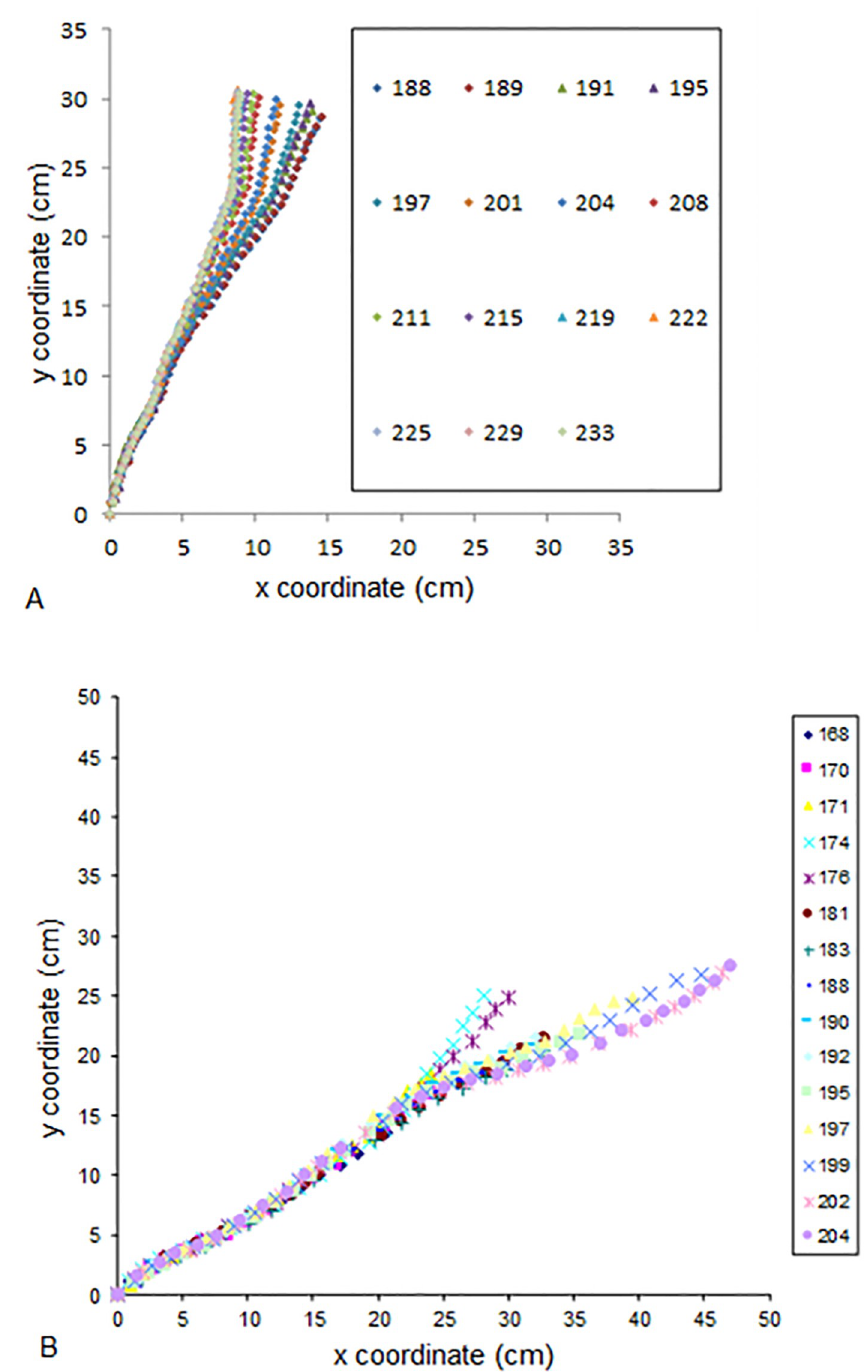
Fig 5. Examples of tropistic movement of oak seedlings subjected to tilting in an isotropic or anisotropic light environment. A: Case of oak seedling subjected to tilting in an isotropic environment: the stem stabilized with the top of the stem back to the vertical. B: Case of oak seedling subjected to tilting in an anisotropic light environment and for which an annual shoot elongated during treatment: the stem stabilized towards light. C: Case of oak seedling subjected to tilting in an anisotropic light environment and for which no annual shoot elongated during treatment: the stem uprighted itself and stabilized around the vertical position.